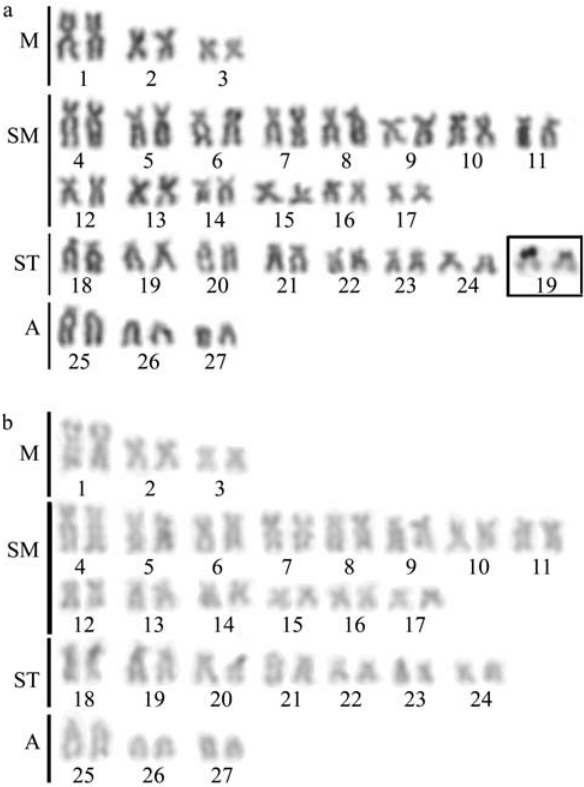
Figure2 -Karyotypeof Microglanis aff. cottoides (2n=54)after:(a)con- ventional staining and (b) C-banding. In the inset, silver stained chromo- somes showing the terminal Ag-NORs on the short arms of pair 23 and long arms of pair